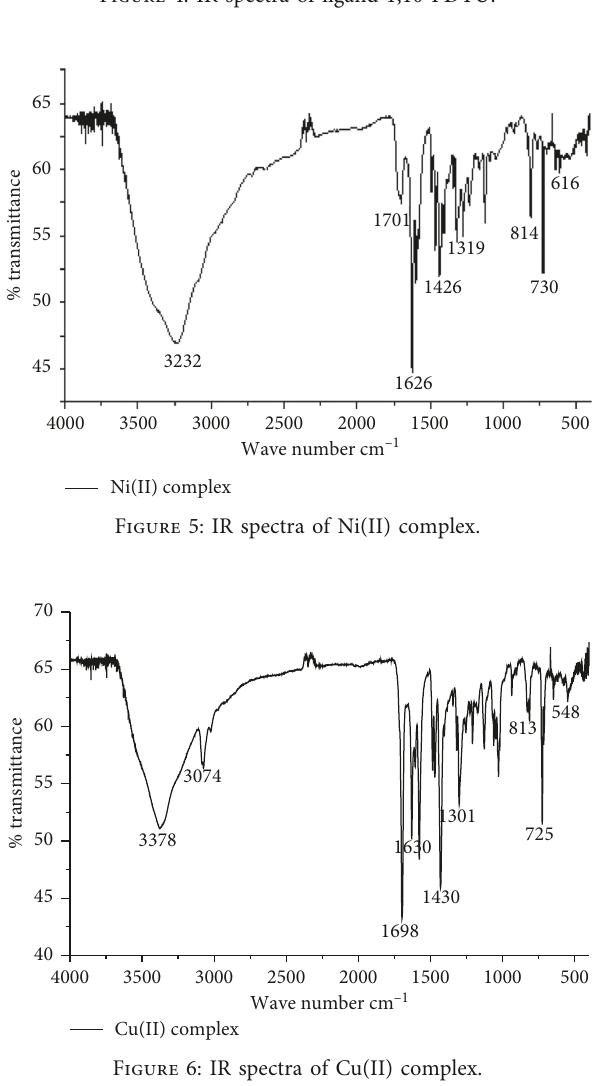
Figure 6: IR spectra of Cu(II)